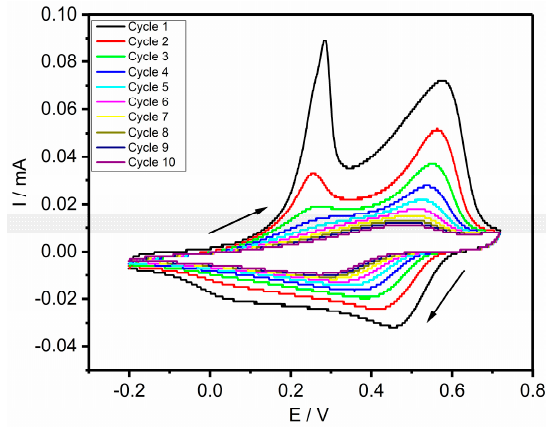
Figure 3. Doped PANI in 0.1 M KBr Solution by cyclic voltammetry.